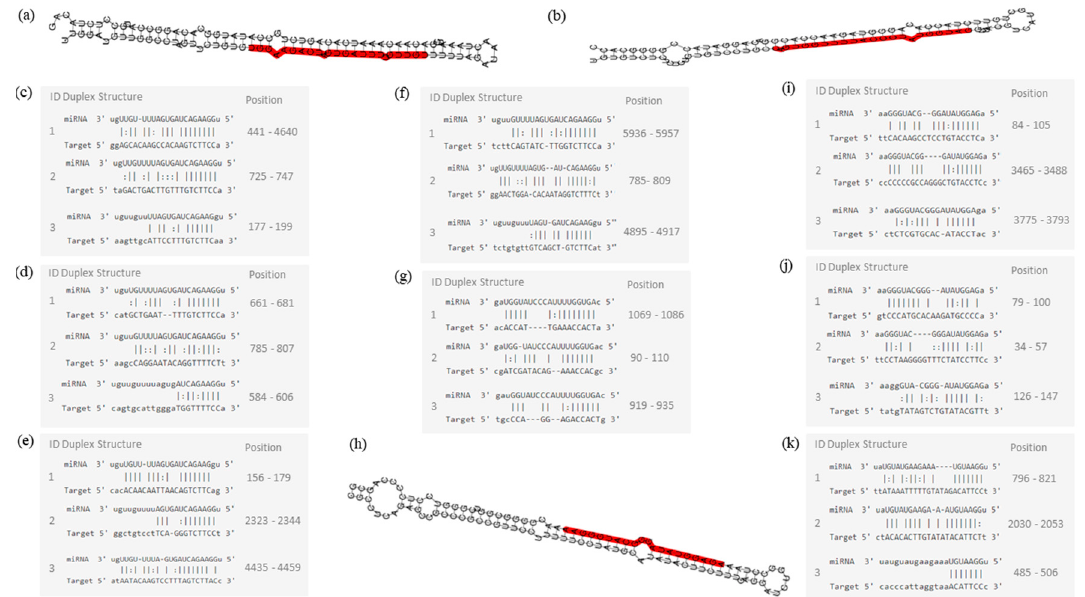
Figure 9. Molecular structures of miR-7-5p, miR-140-5p, and 202-3p. ( a ) Pre-miRNA hairpin of miR-7-5p, second structure of pre-miRNA, and, in red, mature sequence: 24| UGGAAGACUAGUGAUUUUGUUGU |46; ( b ) Pre-miRNA hairpin of miR-140-5p, 2nd structure of pre-miRNA, and, in red, mature sequence: 23| CAGUGGUUUUACCCUAUGGUAG |44; ( c ) miR-7-5p sequence of target interactions—EGFR; ( d ) miR-7-5p sequence of target interactions—RAF1; ( e ) miR-7-5p sequence of target interactions—BCL2 and position in the gene sequence; ( f ) miR-7-5p sequence of target interactions—IGF1R; ( g ) miR-140-5p sequence of target interactions—VEGFA; ( h ) Pre-miRNA hairpin of miR-202-3p, 2nd structure of pre-miRNA, and, in red, mature sequence: 64| AGAGGUAUAGGGCAUGGGAA |83; ( i ) miR-202-3p sequence of target interactions—IGF1R; ( j ) miR-202-3p sequence of target interactions–GLI1; ( k ) miR-1-3p sequence of target interactions—MET. Mature sequence of miR-1-3p: 53| UGGAAUGUAAAGAAGUAUGUAU |74. Pre-miRNA hairpin structure of miR-1-3p is unknown.